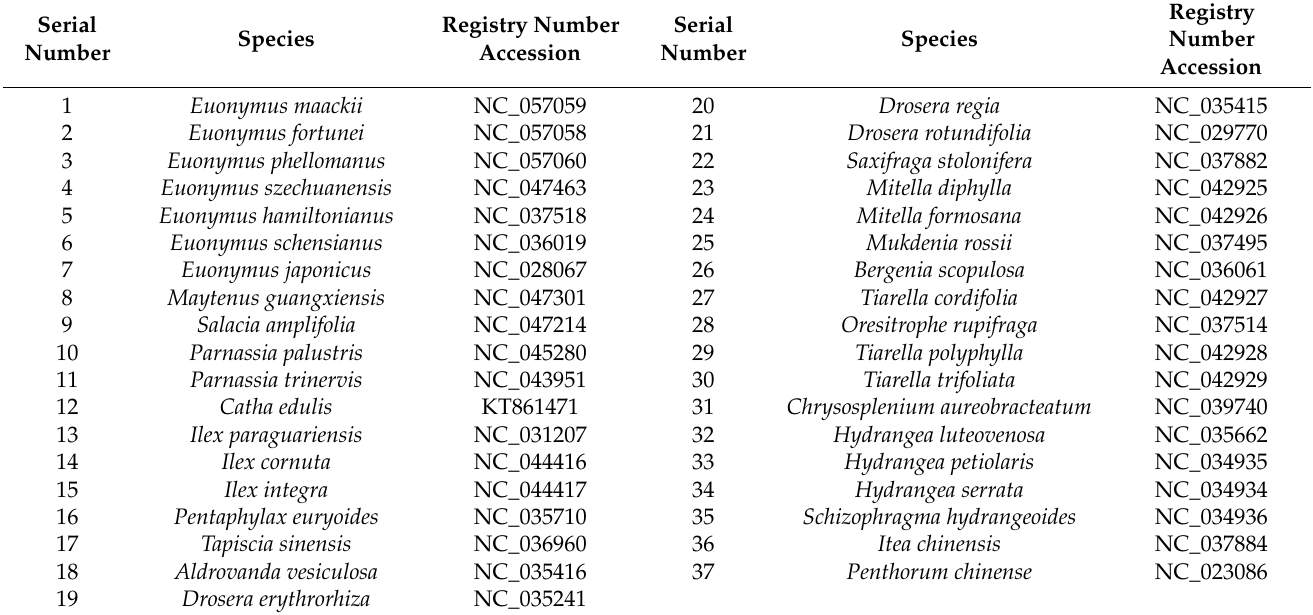
Table 1. Species used for phylogenetic analysis and their NCBI accession